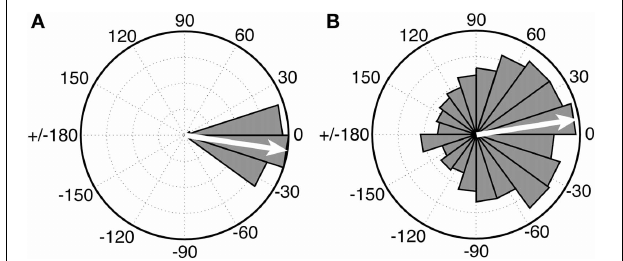
FIGURE 6 | Circular histograms of relative phase values for human (A) vs. chimpanzee (B) taps to an auditory metronome with a period of 600ms. In these plots asynchronies between taps and tones are expressed as relative phase values: 0 ◦ indicates taps perfectly aligned with tones, 180 ◦ indicates taps midway between tones, negative values (e.g., − 15 ◦ ) indicate taps before tones, and positive values (e.g., 15 ◦ ) indicate taps after tones. Human data (Left) from Iversen et al., in press. Chimpanzee data (Right) redrawn from Hattori et al. (2013). In both graphs, the mean relative phase angle is shown with an inset